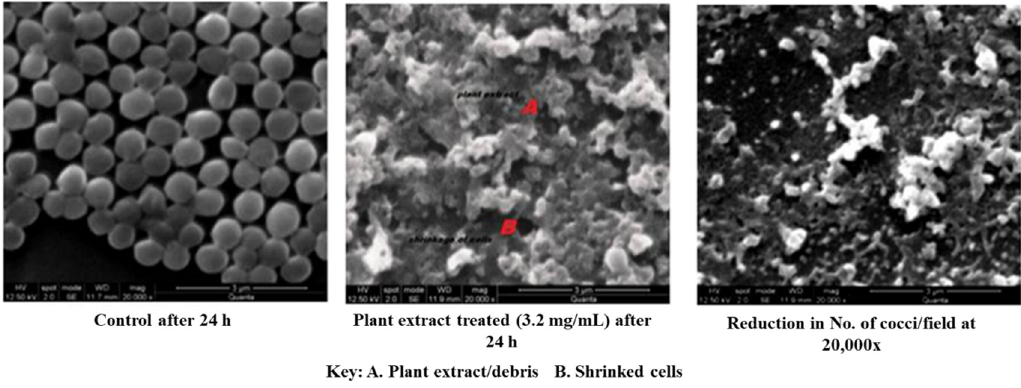
Figure 2. SEM analysis of control and plant extract treated S. aureus .